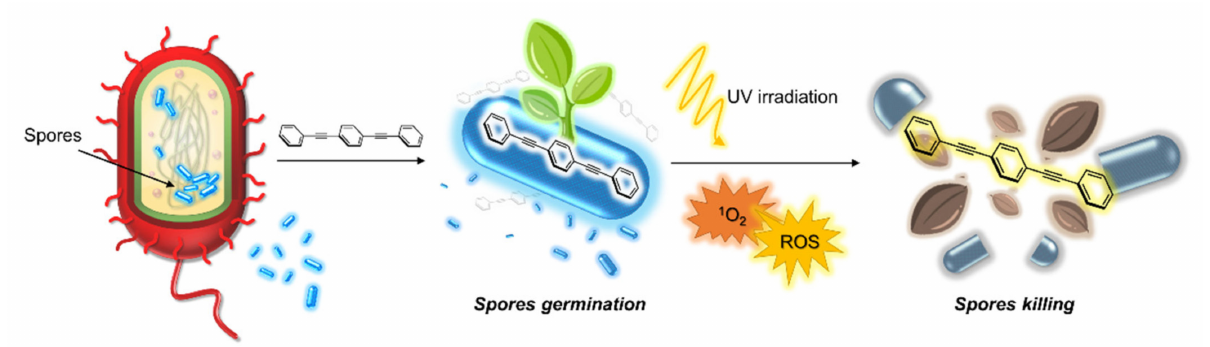
Figure 10. Schematic representation of spore death by the action of some OPE